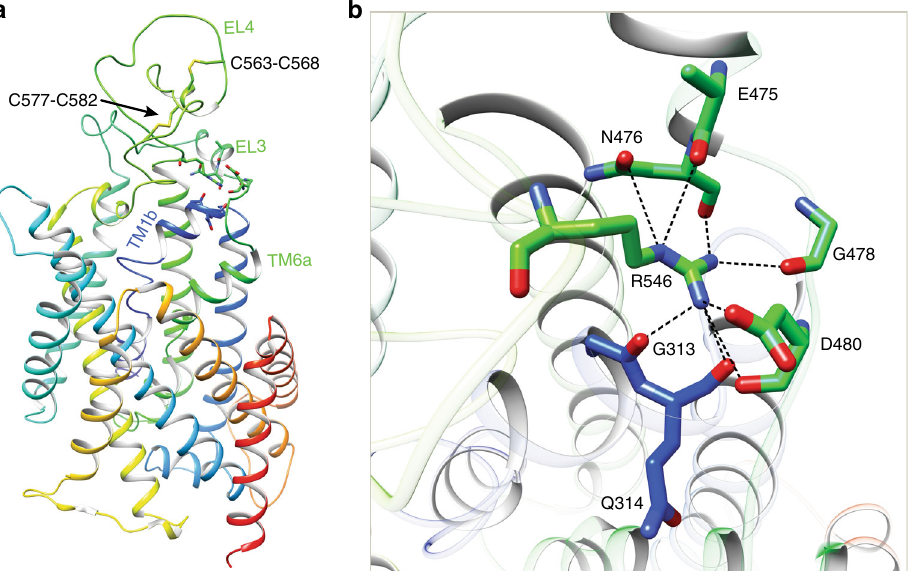
Fig. 2 Extracellular domain of NKCC1 interacts with the transmembrane core. a A NKCC1 subunit is shown in ribbon diagram with rainbow colors from N- to C-termini. Two disul fi de bonds within EL4 are shown as sticks. Residues that mediate contacts among EL3, EL4, and TM1b are also depicted in sticks. b A zoomed view highlights interactions among EL3, EL4, and TM1b. Interactions are denoted with dashed black